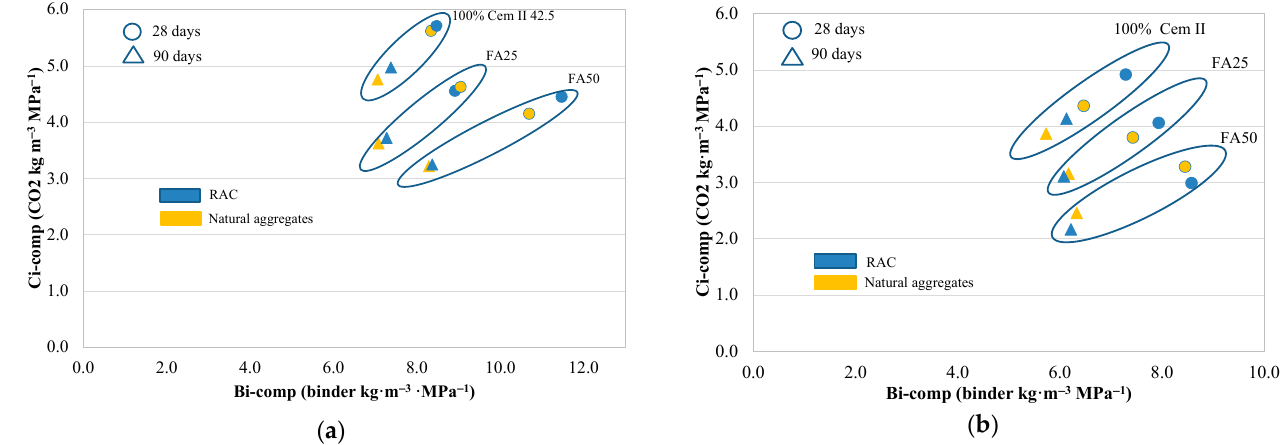
Figure 13. The Bi-comp versus Ci-comp relation for ( a ) Series 1 and ( b ) Series 2.